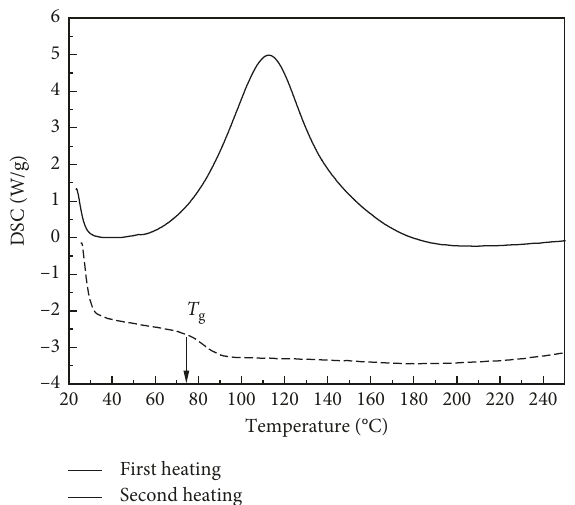
Figure 6: Glass transition temperature determination for the 100/ 35 epoxy/hardener system.